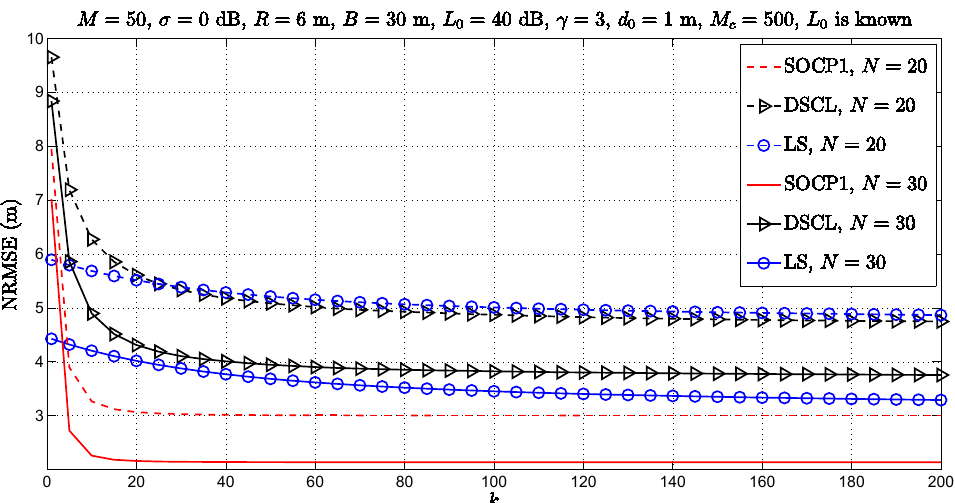
is known: normalized 0